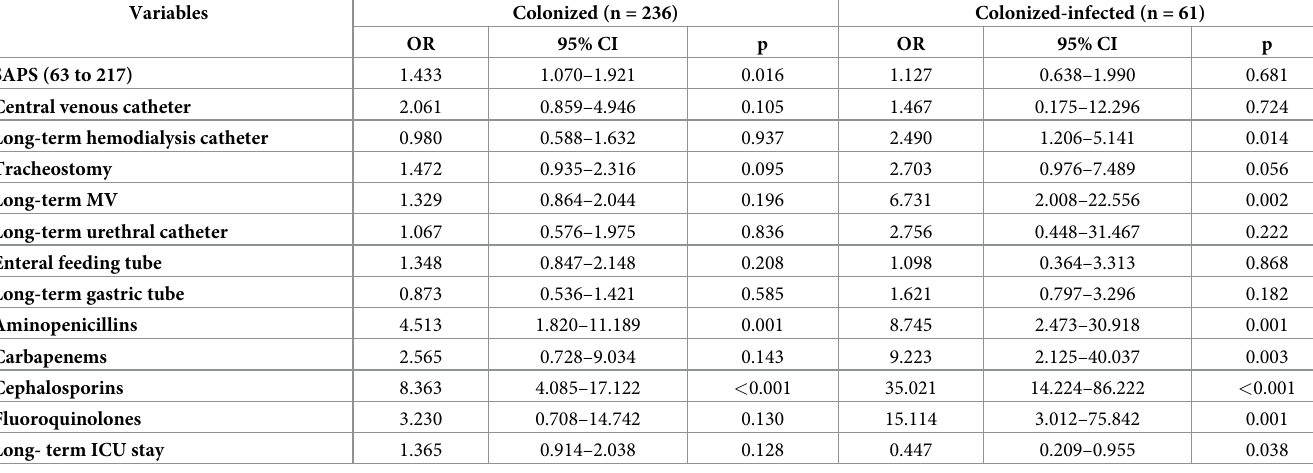
CRE = Carbapenem-resistant Enterobacterales, n = number of patients, OR = odds ratio, 95% CI = confidence interval; p = test significance, SAPS = Simplified Acute Physiology Score, MV = mechanical ventilation, ICU = intensive care unit, n controls =